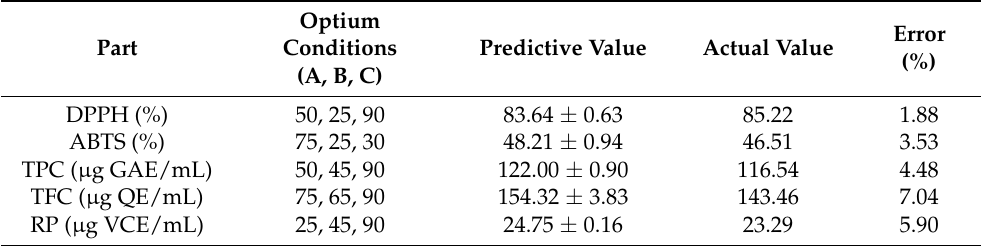
Table 6. The results of optimization of Chenopodium formosanum leaf antioxidant capacity and conditions by the Taguchi